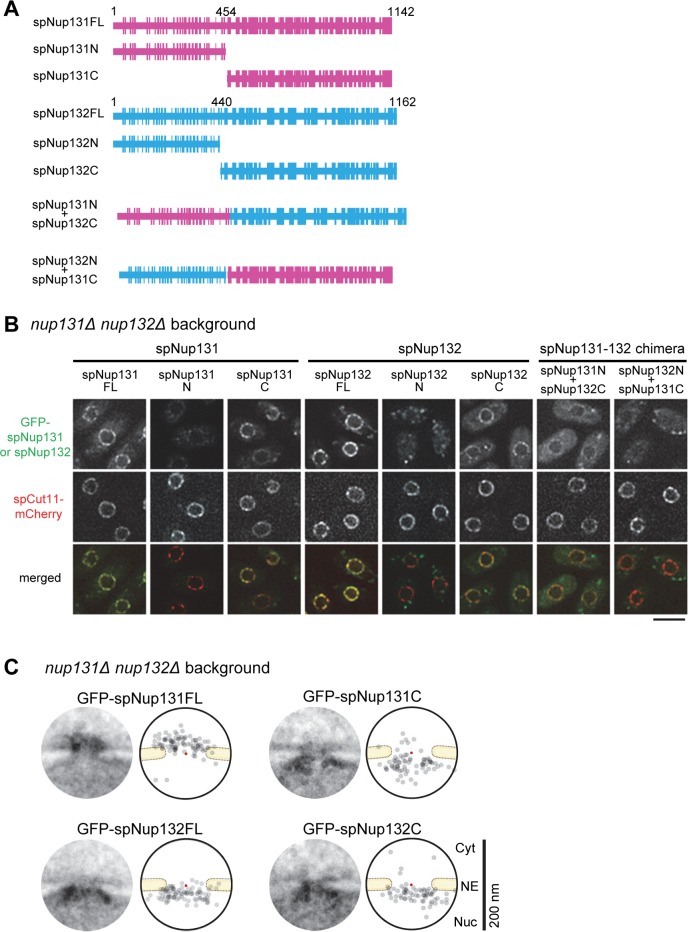
Localization of the spNup131 and spNup132 domains.(A) Schematics of the spNup131 and spNup132 fragments. Magenta represents peptides from spNup131 and light blue represents peptides from spNup132. (B) Localization of spNup131 and spNup132 fragments as determined by FM. GFP-fused fragments were expressed under the spNup132 promoter in the background of the nup131Δ nup132Δ double mutant. Cells were grown on YES plate media for only one day. For this short period of incubation, the NPC-clustering phenotype was not apparent. spCut11-mCherry served as an NPC marker. Single section images of the same focal plane are shown. Scale bar, 5 μm. (C) IEM of the spNup131 and spNup132 fragments. Projection images (left) and immunogold distributions (right) are shown as described in the legend of Fig 1B. The red points indicate the pore centers. IEM micrographs used for the quantitative analysis are available in S10 Dataset.